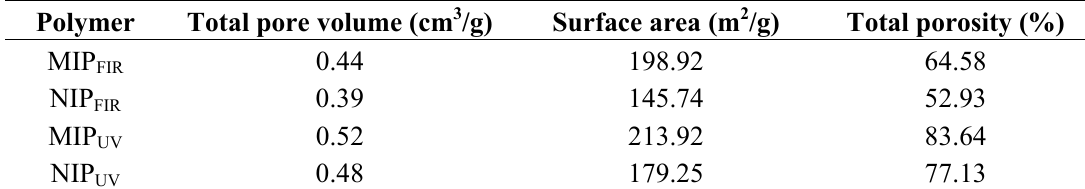
Table 1. Physical properties of the MIPs and NIPs determined by